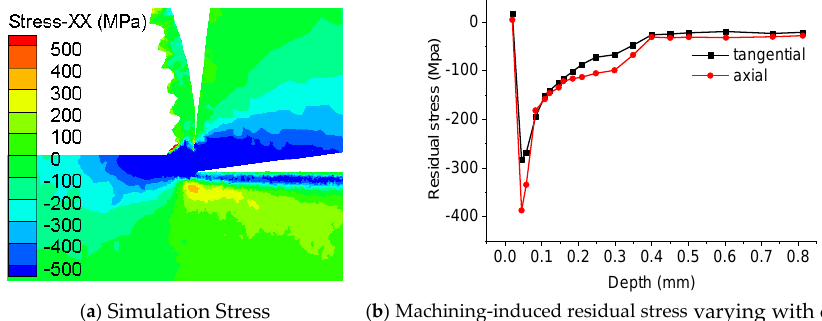
Figure 10. Residual stress after ID turning.